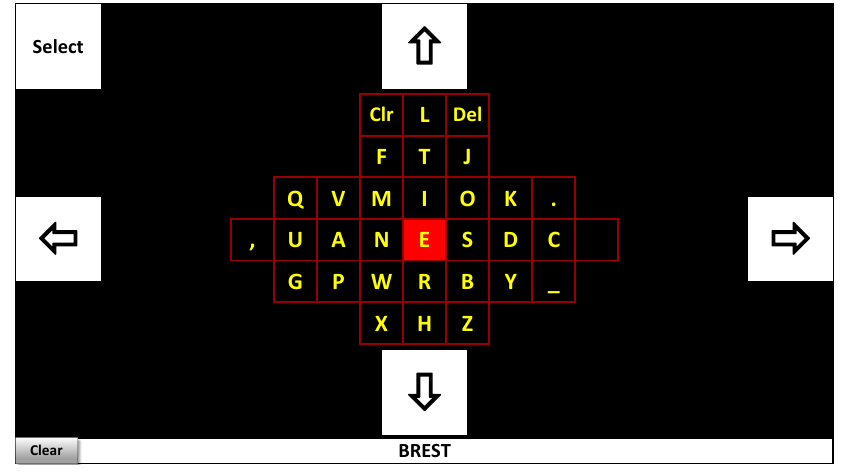
Figure 5. Layout of the Bremen SSVEP-based BCI-speller. Adapted from